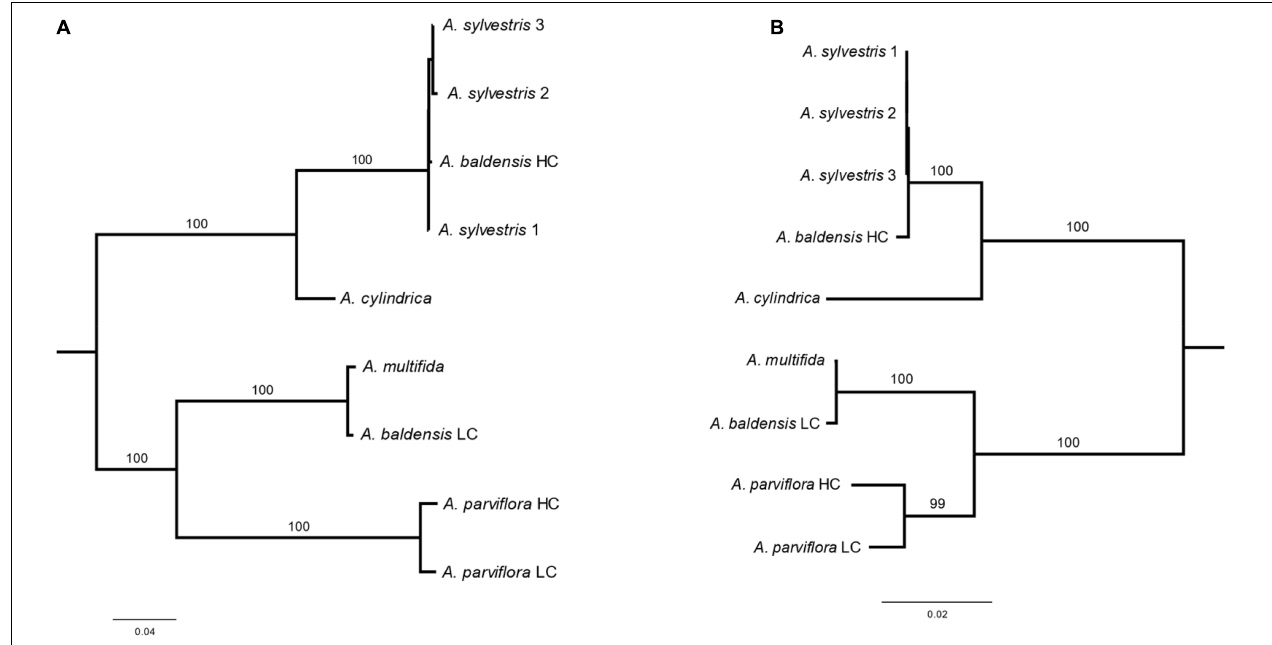
Figure 3 and Supplementary Figure 1 (marked in bold).